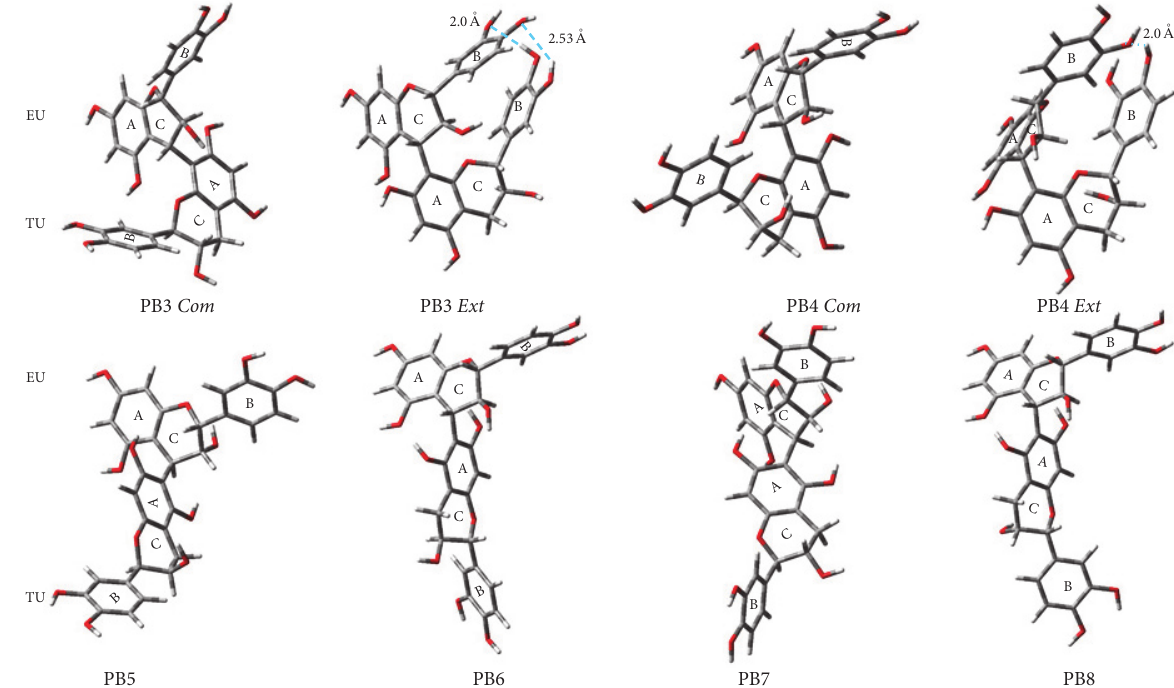
Figure 2: Optimized geometry of the procyanidin dimers in aqueous medium (SMD model) using the M05-2X/6- 31 G ∗∗ DFT method. Com : compact conformation; Ext : extended